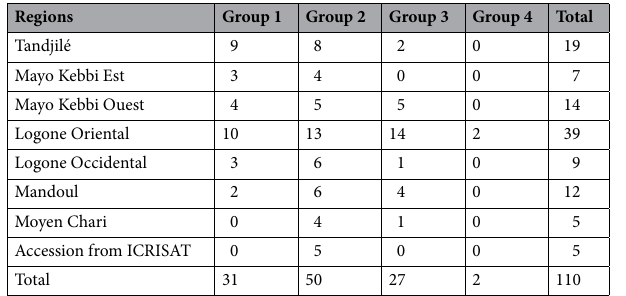
Table 8. Regional distribution of the accessions of Chadian sweet sorghum following Ward’s hierarchical clustering into four major groups.